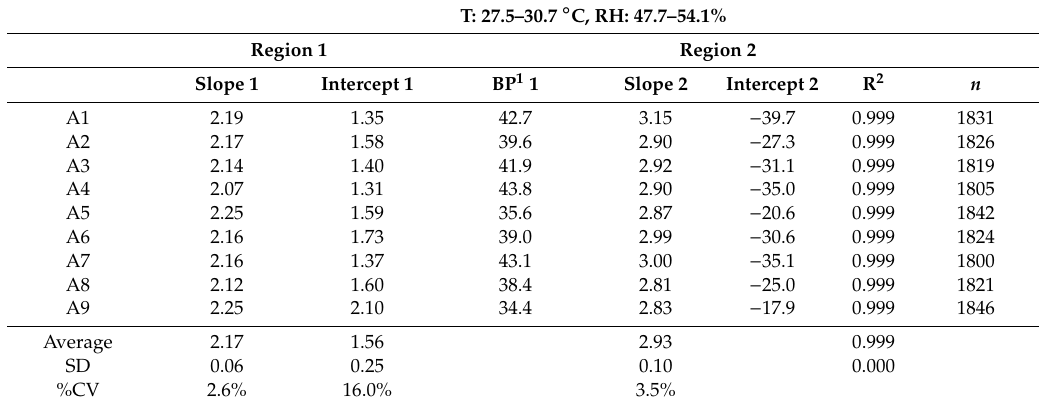
Table 6. Segmented regression equations from the chamber experiments with mosquito coils for ( a ) 0.1–200 µ g / m 3 of PM 2.5 , ( b ) 0.1–200 µ g / m 3 of PM 1 , ( c ) 0.1–300 µ g / m 3 of PM 2.5 , and ( d ) 0.1–400 µ g / m 3 of PM 2.5 . (a) PM